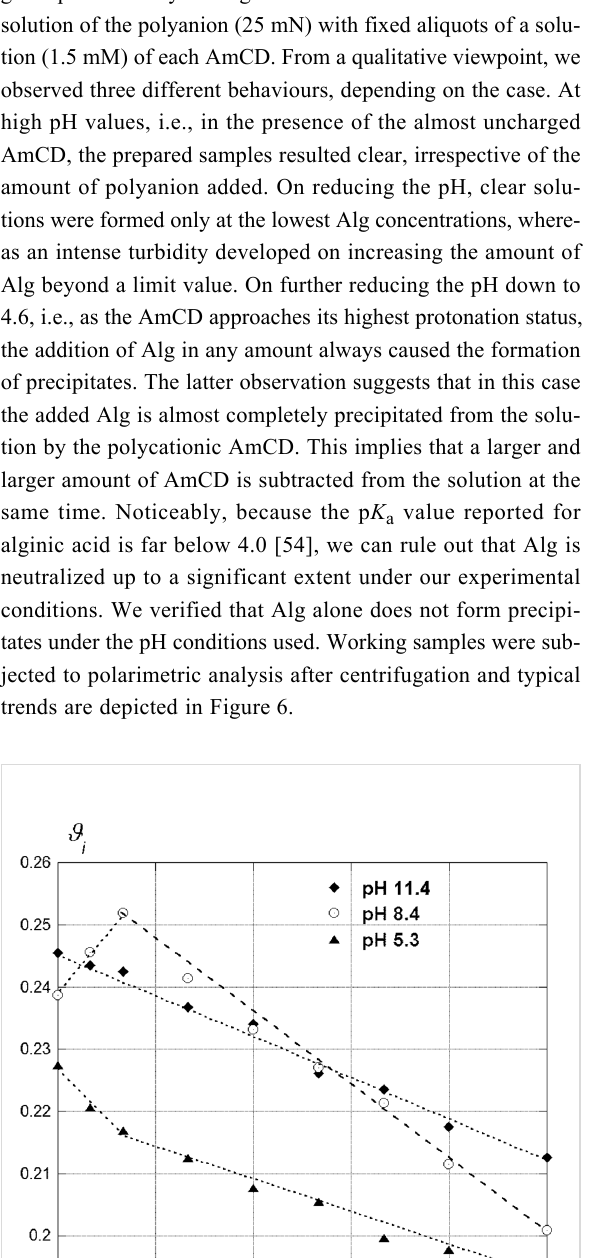
points under examination were: i) the stoichiometry of the possible complex formed and ii) the intimate mechanism of the